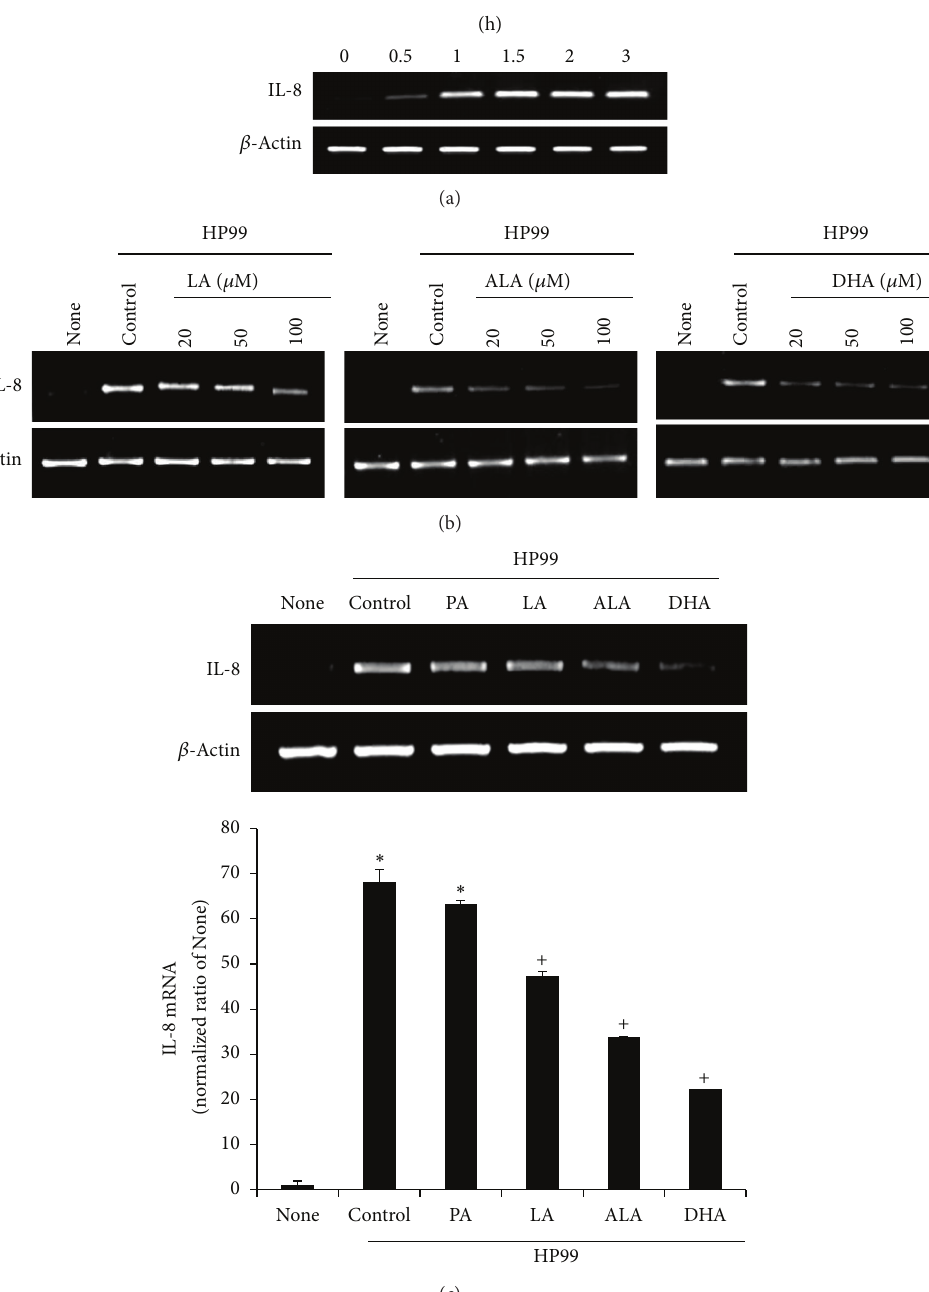
Figure 2: Effects of PUFAs on IL-8 mRNA expression in H. pylori -infected AGS cells. (a) AGS cells were cultured with H. pylori for the indicated time periods (0.5, 1, 1.5, 2, and 3 h) and IL-8 mRNA expression was measured by RT-PCR. (b) AGS cells were pretreated with various concentrations of LA, ALA, and DHA (20, 50, and 100 𝜇 M) for 24 h and were then cultured with H. pylori for 2h. (c) AGS cells were pretreated with individual fatty acid (100 𝜇 M) for 24 h and then stimulated with H. pylori for 2h. mRNA levels of IL-8 were quantified by real-time PCR. Data was normalized to 𝛽 -actin level and expressed as relative ratio to None. Each bar represents mean ± S.E. of four separate experiments. ∗ 𝑃 < 0.01 versus None; + 𝑃 < 0.01 versus